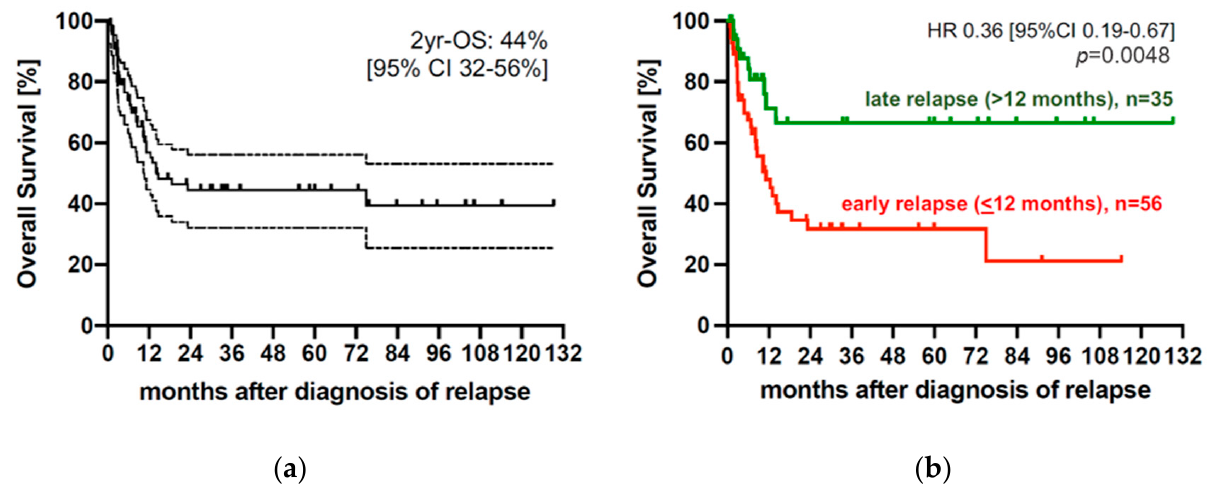
Figure 2. Outcome after post-transplant relapse. ( a ) Overall survival of the whole cohort ( n = 91), median OS of the whole cohort was 14.1 months (range 0.8–129.3 months) corresponding to a 2-yr OS of 44% [95% CI 32–56%] after relapse. ( b ) Outcome of patients with early and late relapses, patients with late (green line, n = 35) relapse showed a significantly improved outcome compared with patients with early (red line, n = 56) relapse (2-yr OS 66.5% vs. 31.7%, p = 0.0048). Accordingly, the hazard to die after a late relapse was significantly lower than that after an early relapse (HR 0.36 [95%CI 0.19–0.67], p = 0.0048). Allo-SCT, allogeneic hematopietic stem-cell transplantation; HR, hazard ratio; CI, cumulative incidence; OS, overall survival; yr, year.